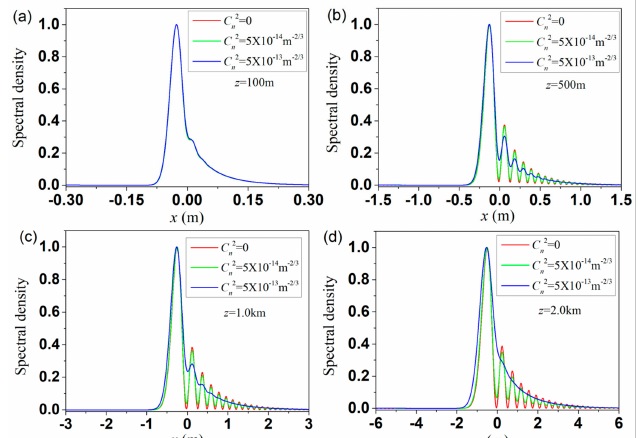
Figure 2. Normalized 1D spectral densities of MCLGC beams in turbulence with different structure constants at four different propagation distances. ( a – d ) the propagation distances are z = 100 m, 500 m, 1.0 km and 2.0 km, respectively.